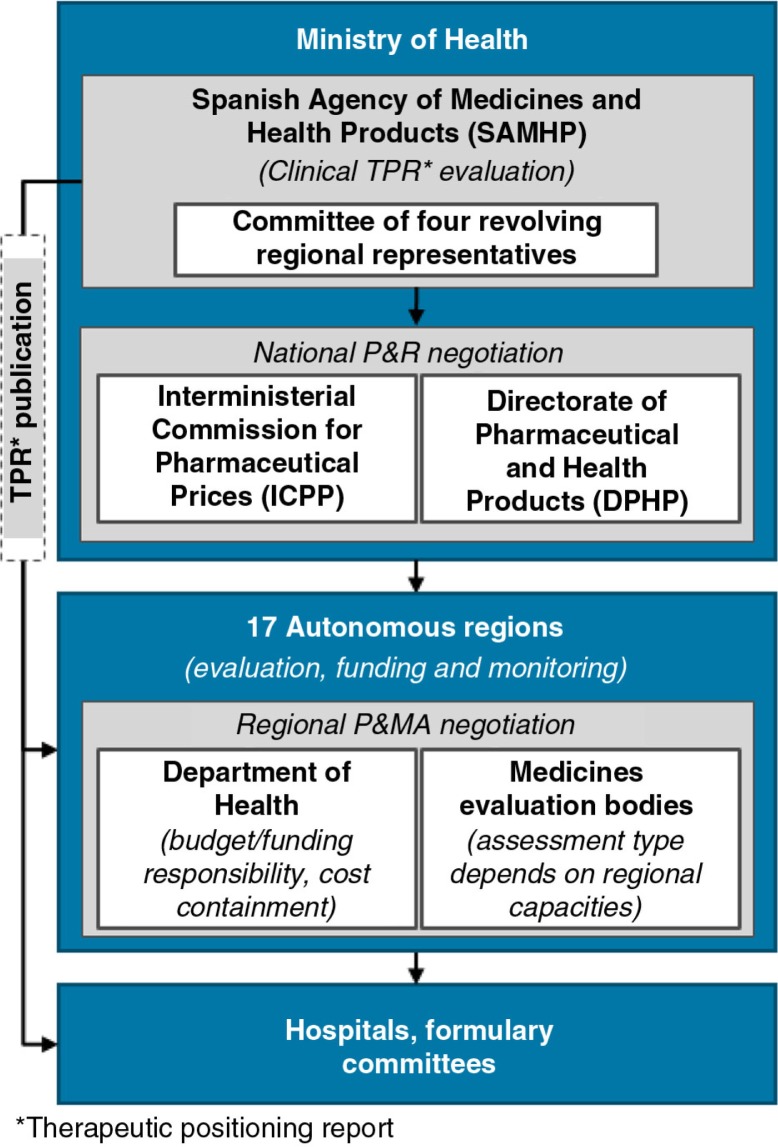
Market access pathway in Spain.